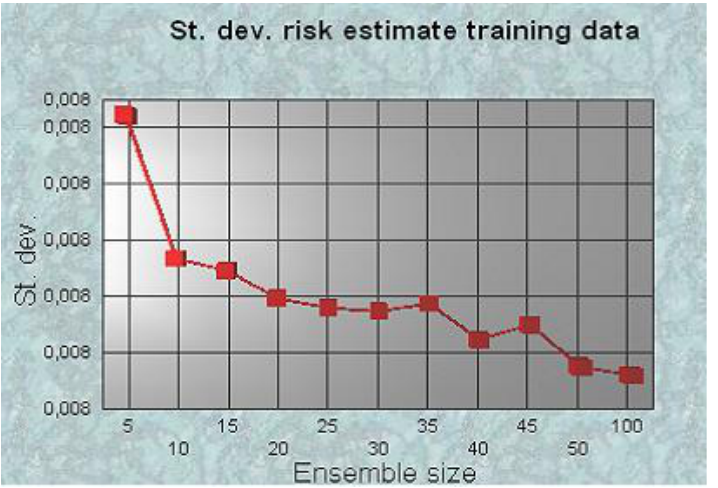
Figure 2: Relationship between ensemble size and standard deviation of risk estimate for training